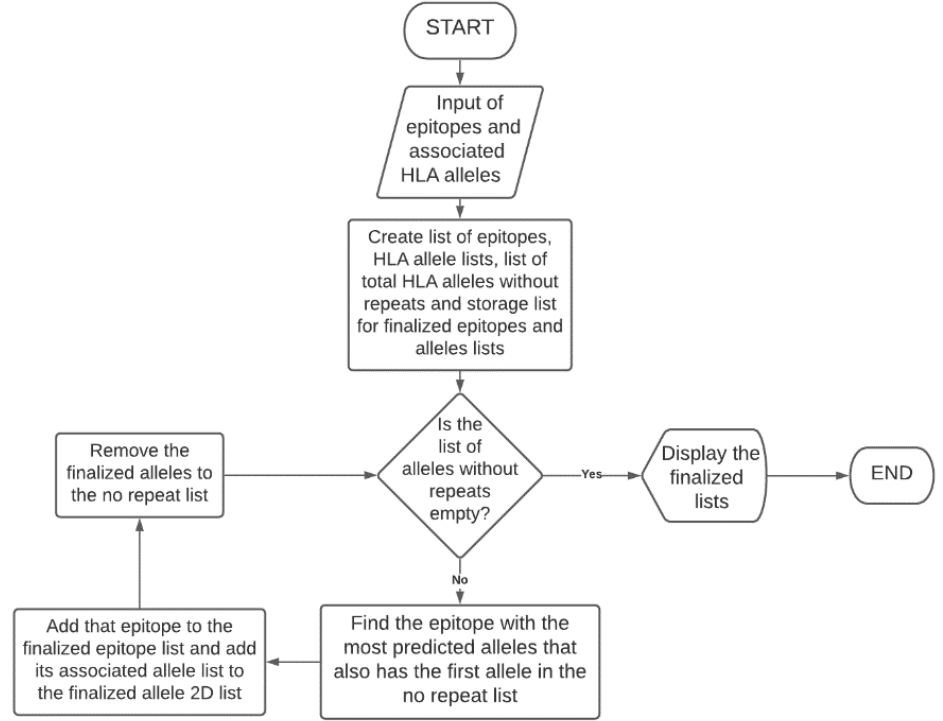
Figure 3. Logical work flow process of PopCoverageOptimization program to optimize peptide selection. The program obtains maximum population coverage by selecting for epitopes that bind to each predicted HLA allele. Small epitope count is sacrificed for population coverage in this model.